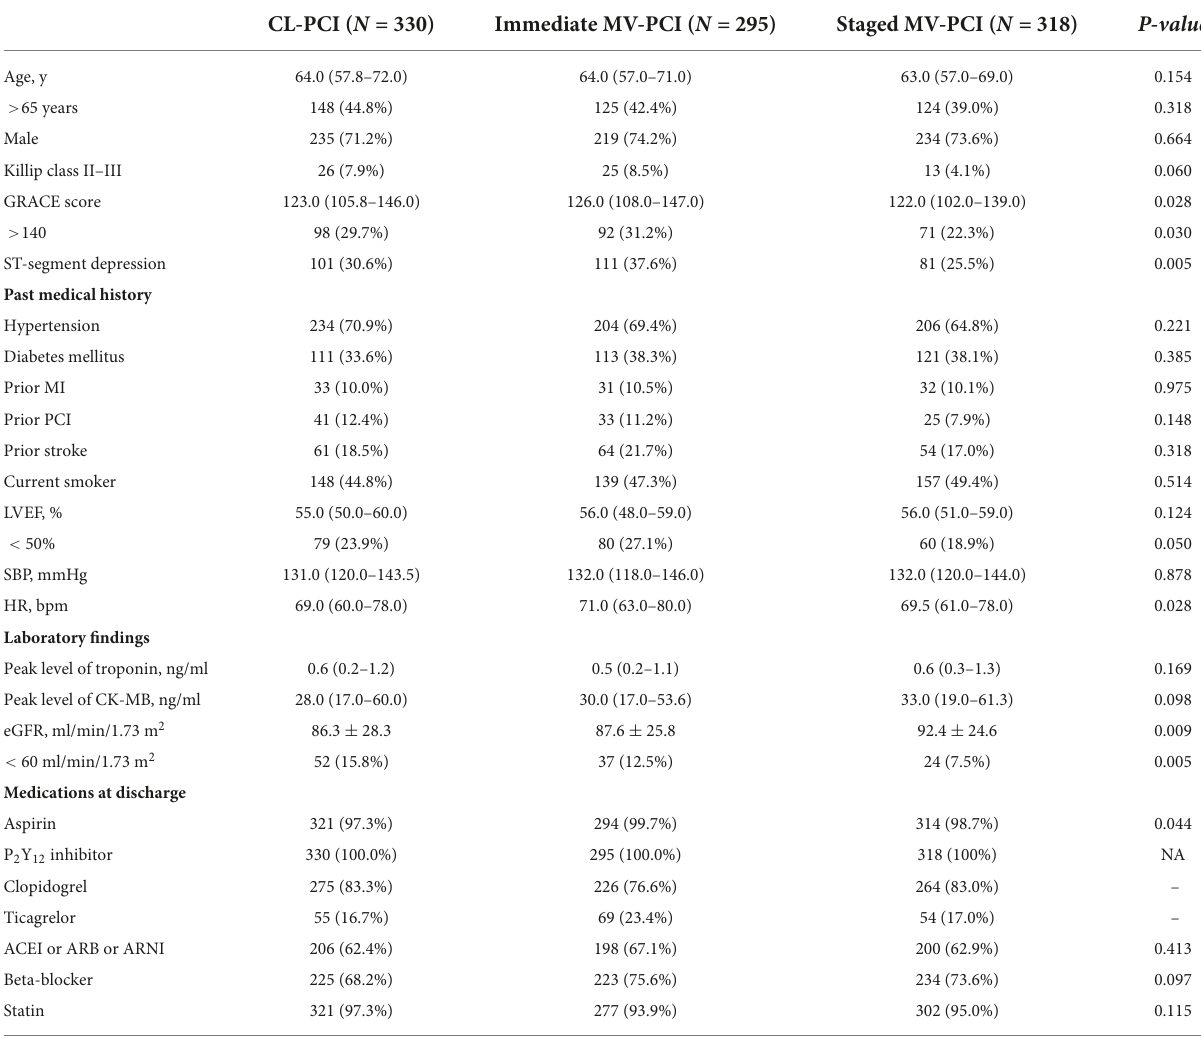
TABLE 1 Baseline clinical